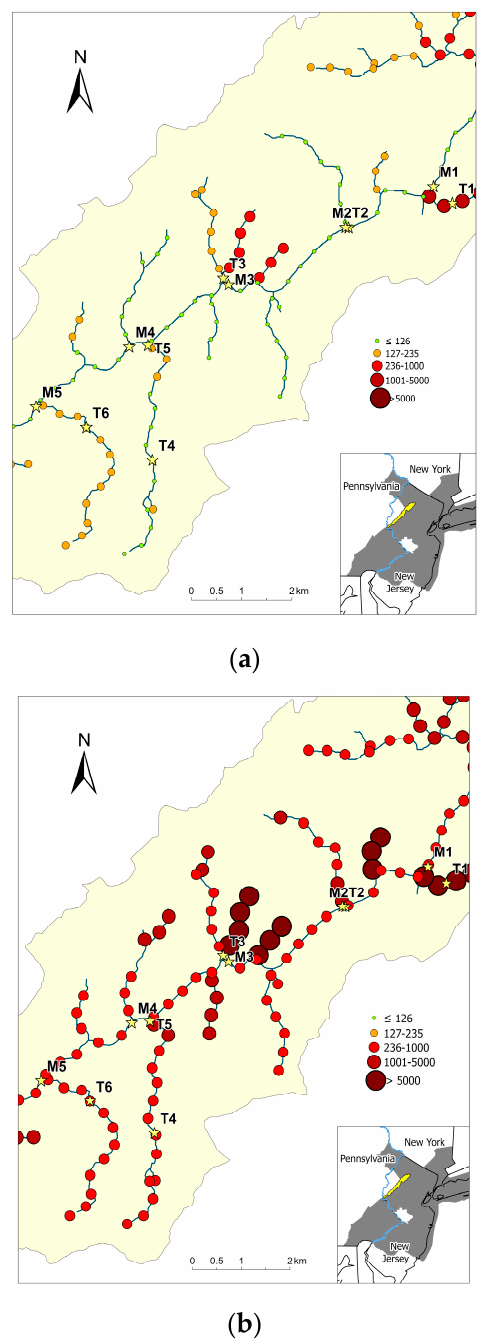
Figure 4. Prediction of ( a ) overall geometric mean concentrations of E. coli and ( b ) geometric mean concentrations of E. coli during storm events. Color and size of the circles denote the geometric mean concentrations of E. coli , with larger and darker circles indicating greater geometric mean concentrations of E. coli . Stars indicates the sampling locations in this study.